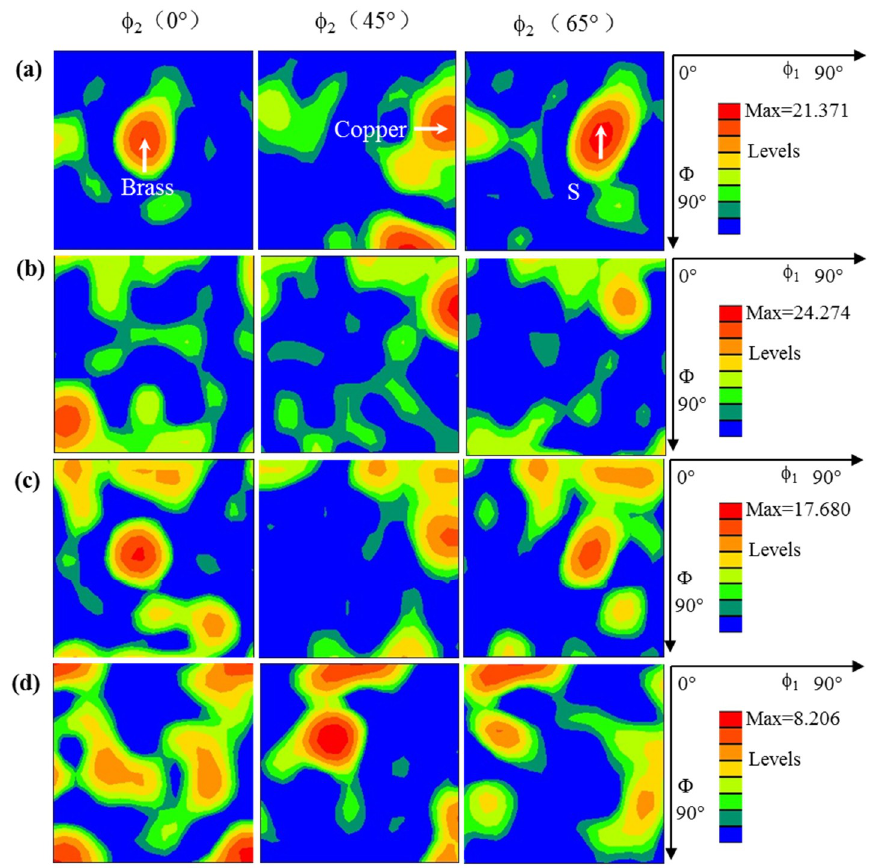
Figure 8. EBSD images of the experimental alloys annealed under different annealing temperatures for 1 h. Ce-containing alloy: ( a ) 450 °C; ( b ) 520 °C; Ce-free alloy: ( c ) 450 °C; ( d ) 520 °C.